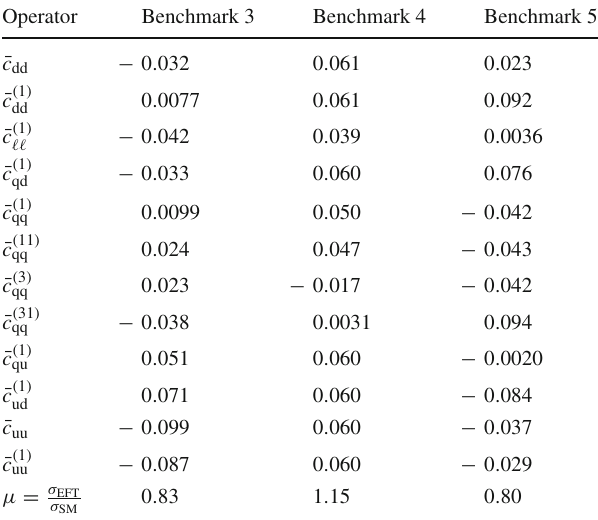
Table 2 Benchmarks for four-fermion operators. ¯ c i = c i v 2 (cid:2) ber of significant digits used has been reduced in this table for the purpose of clarity. We have neglected the operators containing colour structures since they are very suppressed in this process, as shown in Eq.